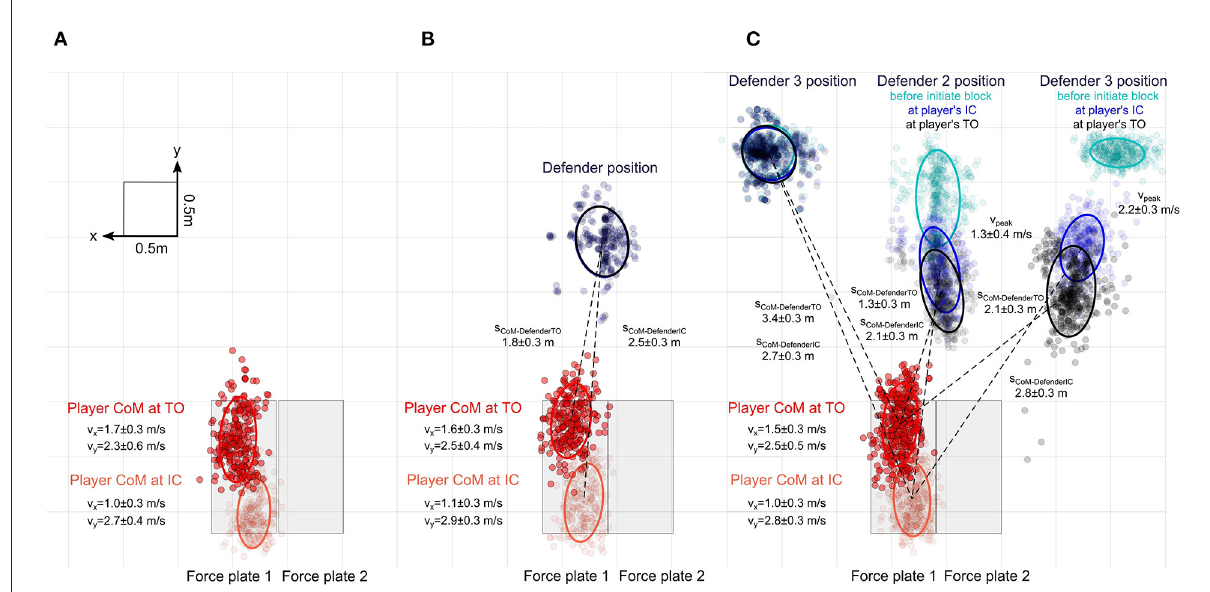
FIGURE4 Bird’s eye view of the dynamic testing situations. (A) Kinematics of the center of mass (CoM) and the point of force application (PoFA) for each cut at initial contact (IC) and toe-off (TO) for task 1. (B) Kinematics of the CoM for each cut at IC and at TO, and the position of the static defender for Task 2. (C) Kinematics of the CoM for each cut at IC and TO for task 3. Turquoise dots visualize the position of each defender before initiating the block, blue dots represent the defenders’ position at the instance of the athletes’ IC, and black dots represent the defenders’ positions at the athletes’ TO. Dashed lines represent the average distance to the respective regions. Ellipses around regions visualize standard deviations.